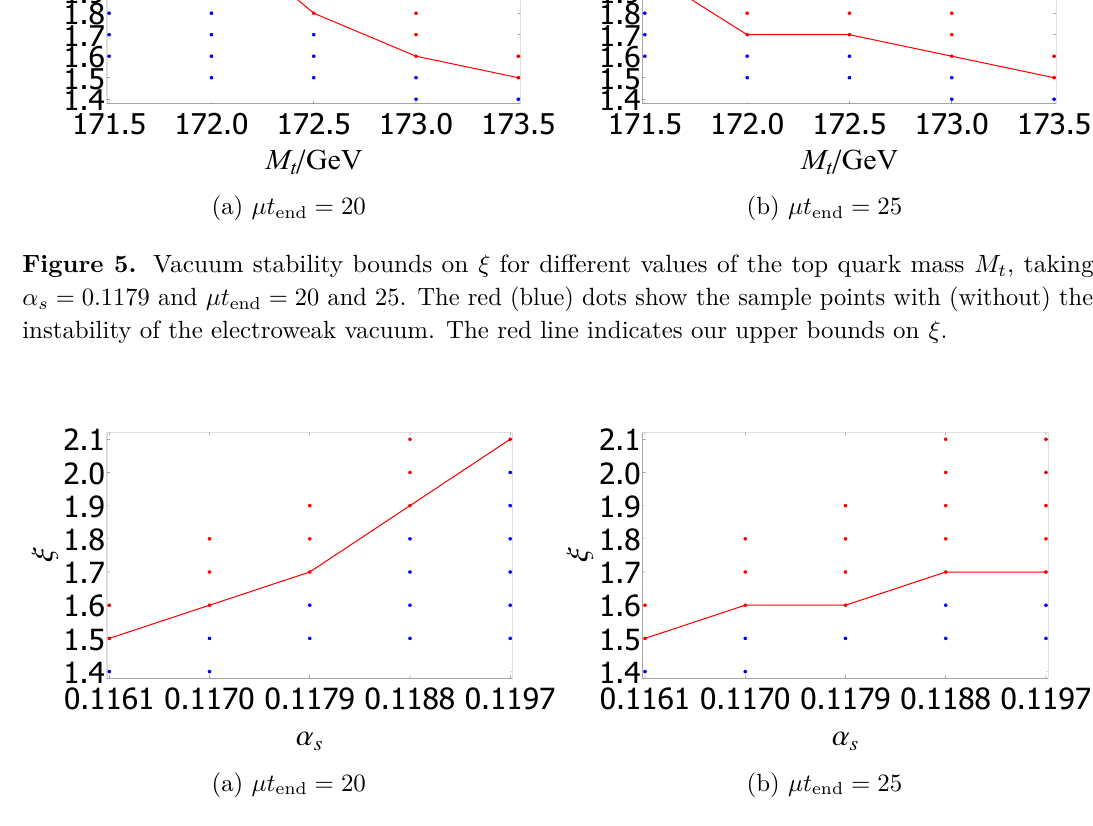
Figure 6. Vacuum stability bounds on ξ for different values of the strong coupling α s , taking M t = 172 . 76 GeV and µt end = 20 and 25 . The red (blue) dots show the sample points with (without) the instability of the electroweak vacuum. The red line indicates our upper bounds on ξ